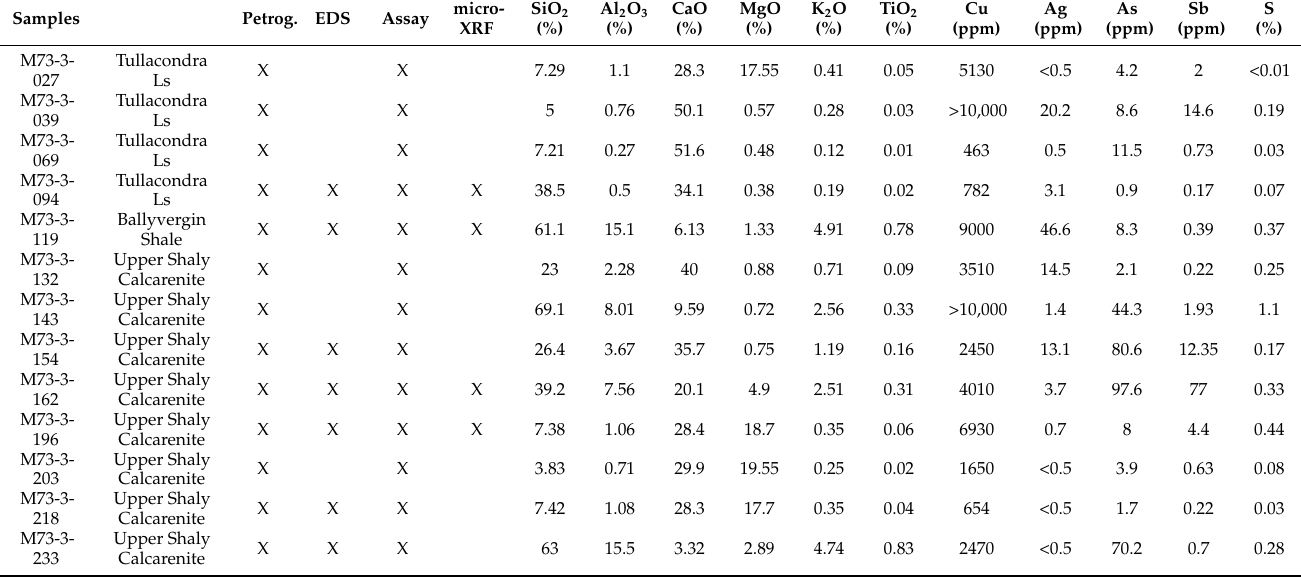
Table A3. Geochemical